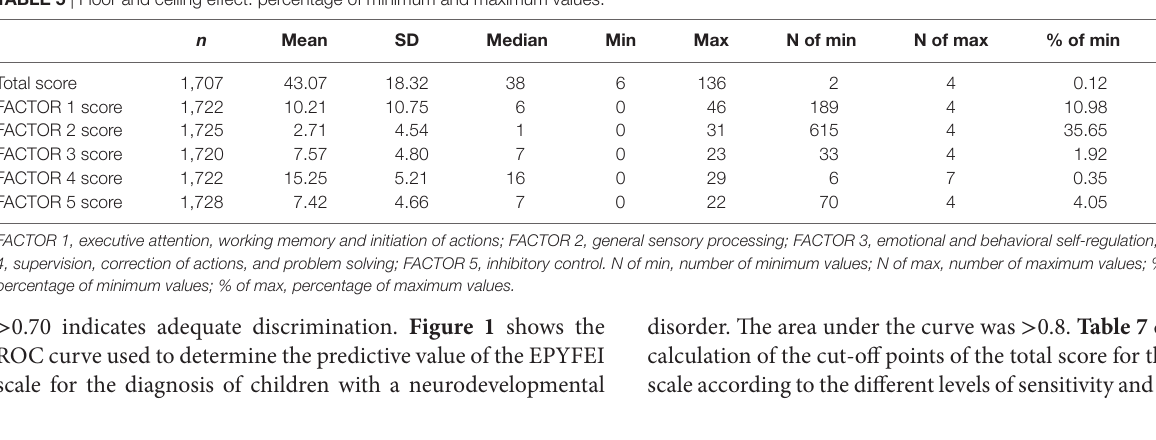
tAble 5 | Floor and ceiling effect: percentage of minimum and maximum values.